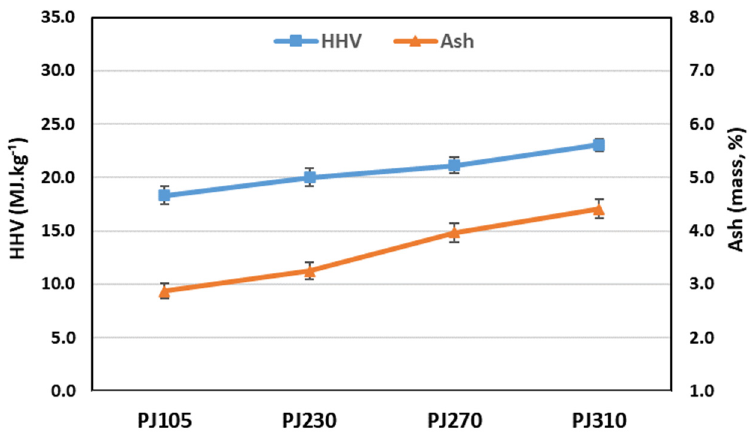
Figure 4. Profiles of the HHV and ash content of the P. juliflora samples.